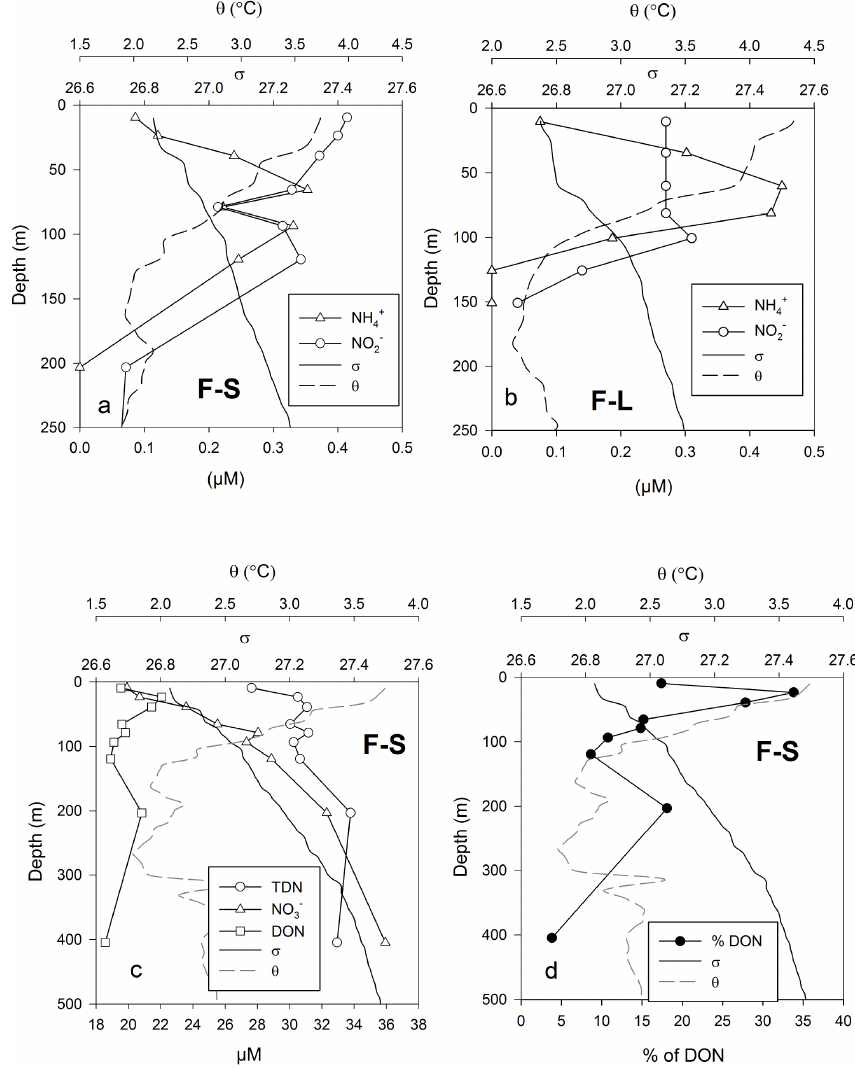
Figure 5. Dissolved nitrogen speciation at stations F-L and F-S during